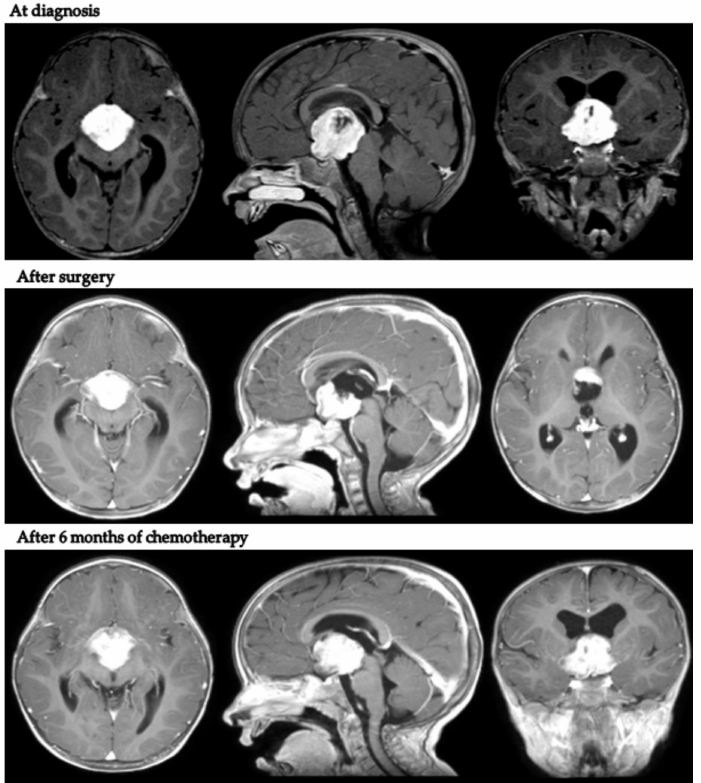
Figure 2. Axial, coronal and sagittal post-contrast T1-weighted MRIs of patient 9 at diagnosis, after neurosurgical biopsy and after the LGG 2004 induction protocol (1st progression).